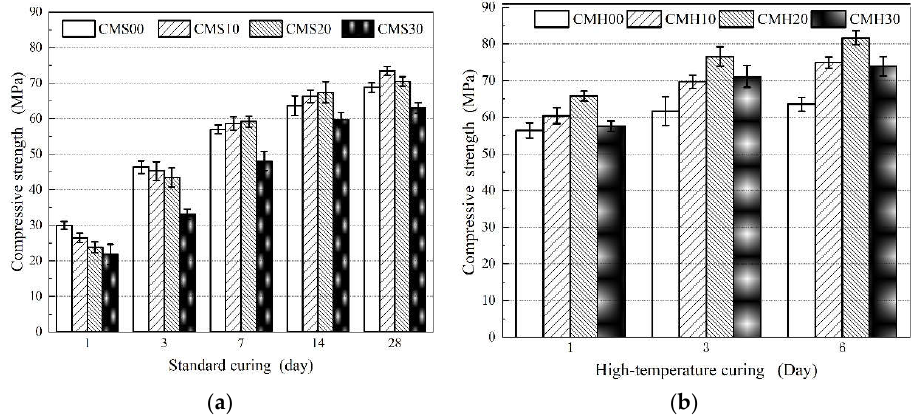
Figure 2. Compressive strength development of the composite cement-based material under standard curing ( a ) and high temperature curing ( b ).